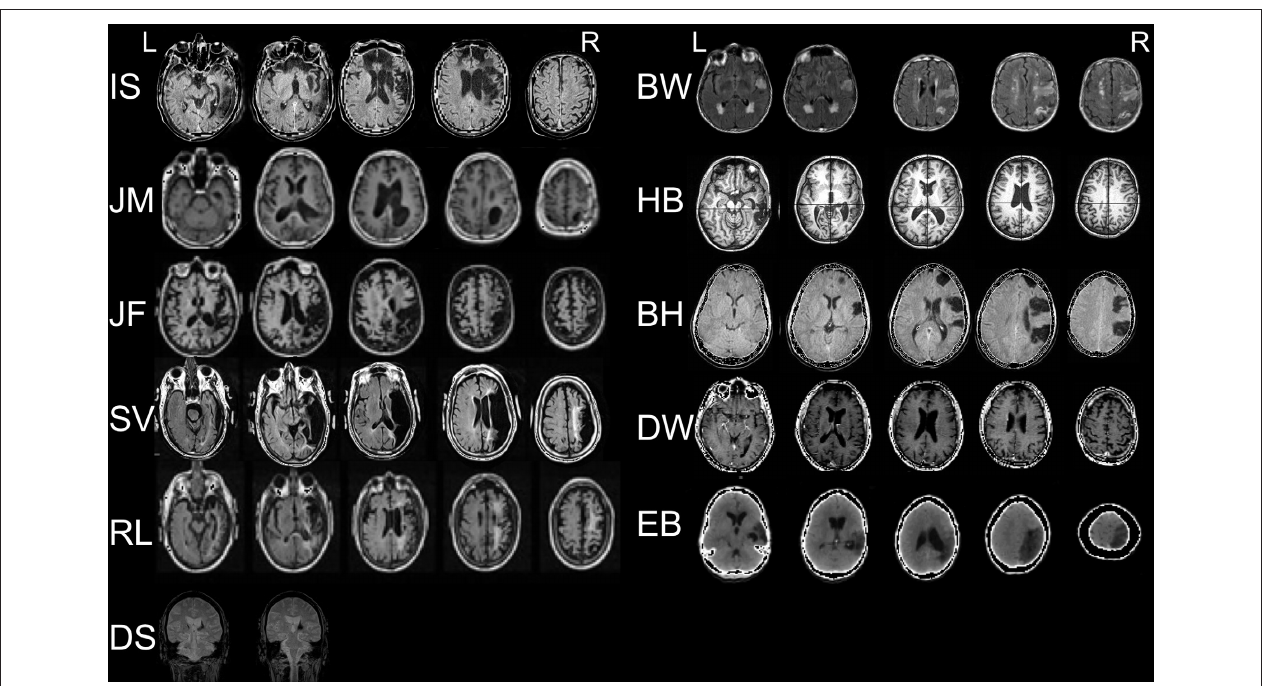
Figure 1 | Mri and CT scans of patients’ lesions in neurological convention (excluding patient JS).